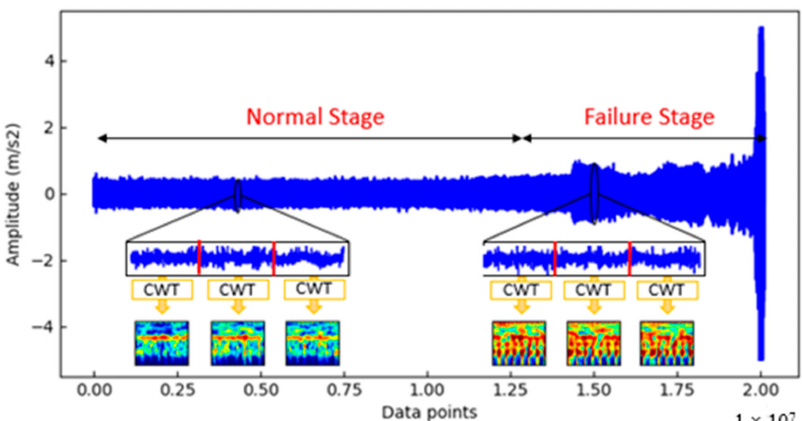
Figure 2. The lifespan of a bearing is divided into the normal stage and failure stage, and the healthy dataset is established from the normal stage data.